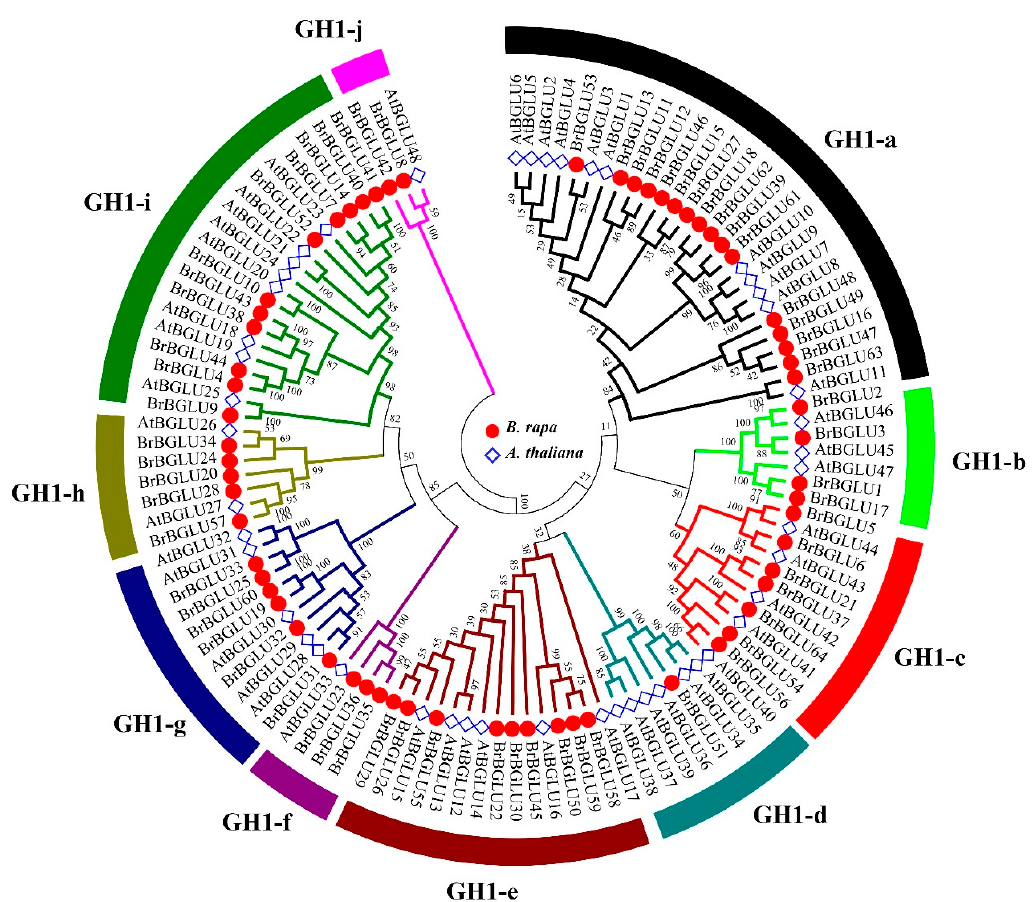
Figure 2. Phylogenetic reconstruction of GH1 genes of Arabidopsis and Brassica rapa . Multiple sequence alignment of GH1 proteins was performed using ClustalX2 with default parameters. The unrooted phylogenetic tree was constructed by MEGA 6 with the neighbor-joining (NJ) methods using the following parameters: bootstrap values (1,000 replicates) and Poisson model. The tree is divided into 11 phylogenetic subgroups, designated as GH1-a to GH1-k. Members of Arabidopsis and B. rapa are denoted by blue squares and red circles.